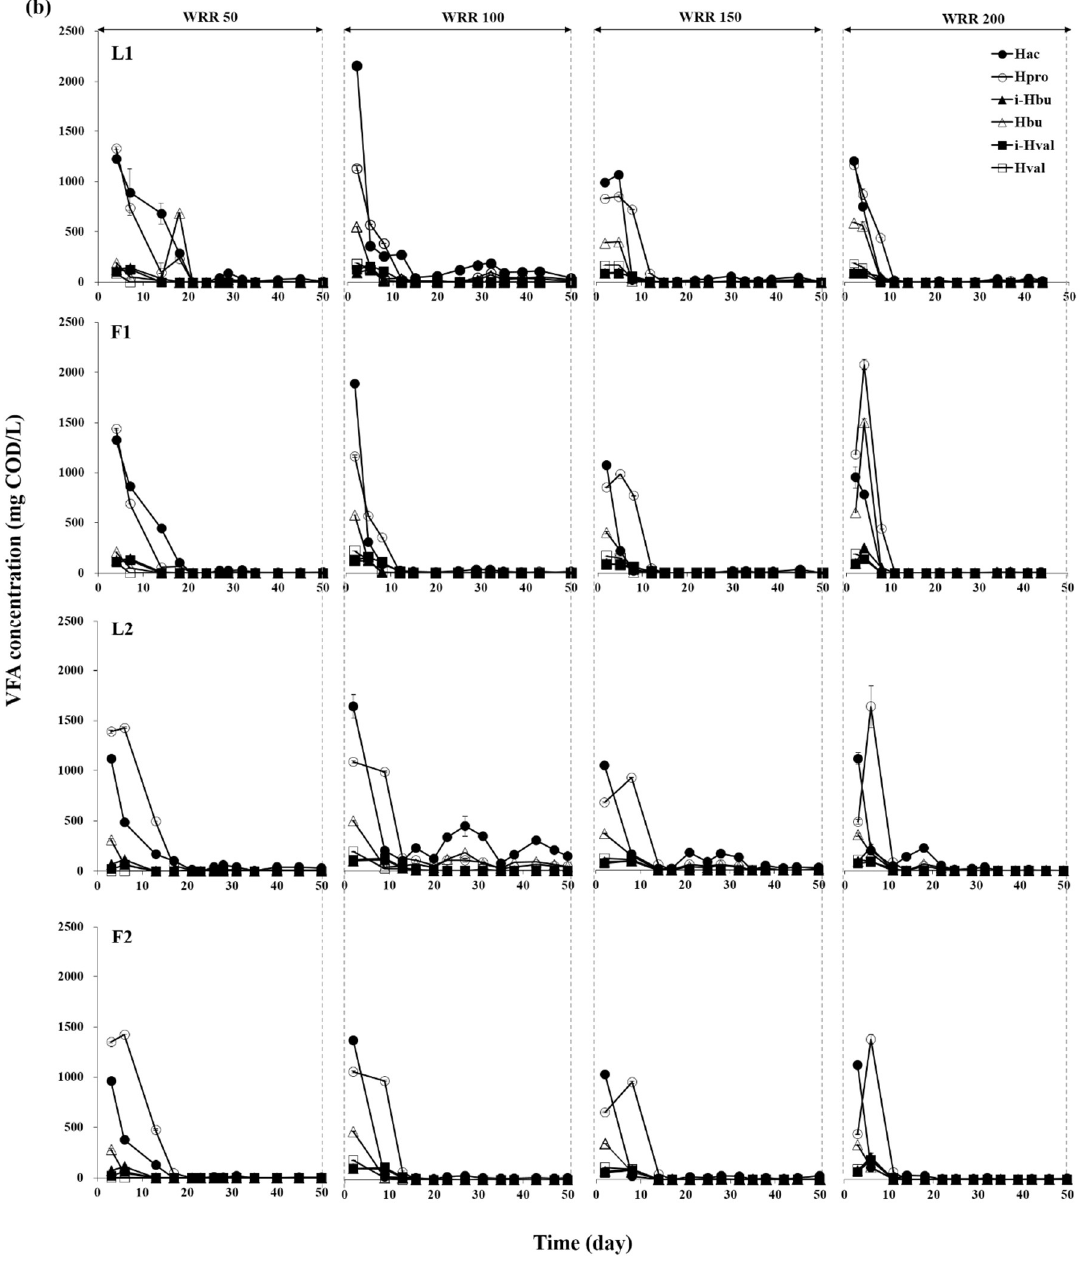
Figure 3. Total ( a ) and individual ( b ) VFA profiles of the LBR and AF in R1 and R2 during the batch experiment at each WRR (mL/d).